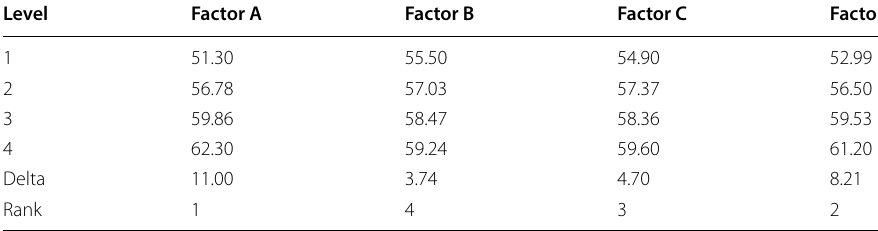
Table 6 Taguchi response table for heat transfer rate in EATHE system